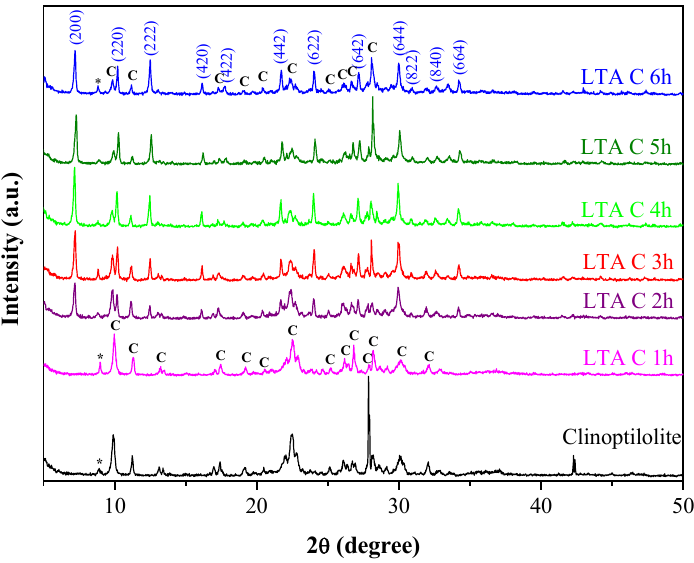
Figure 6. Diffractograms of LTA zeolites from clinoptilolite. (* is an unidentified peak)